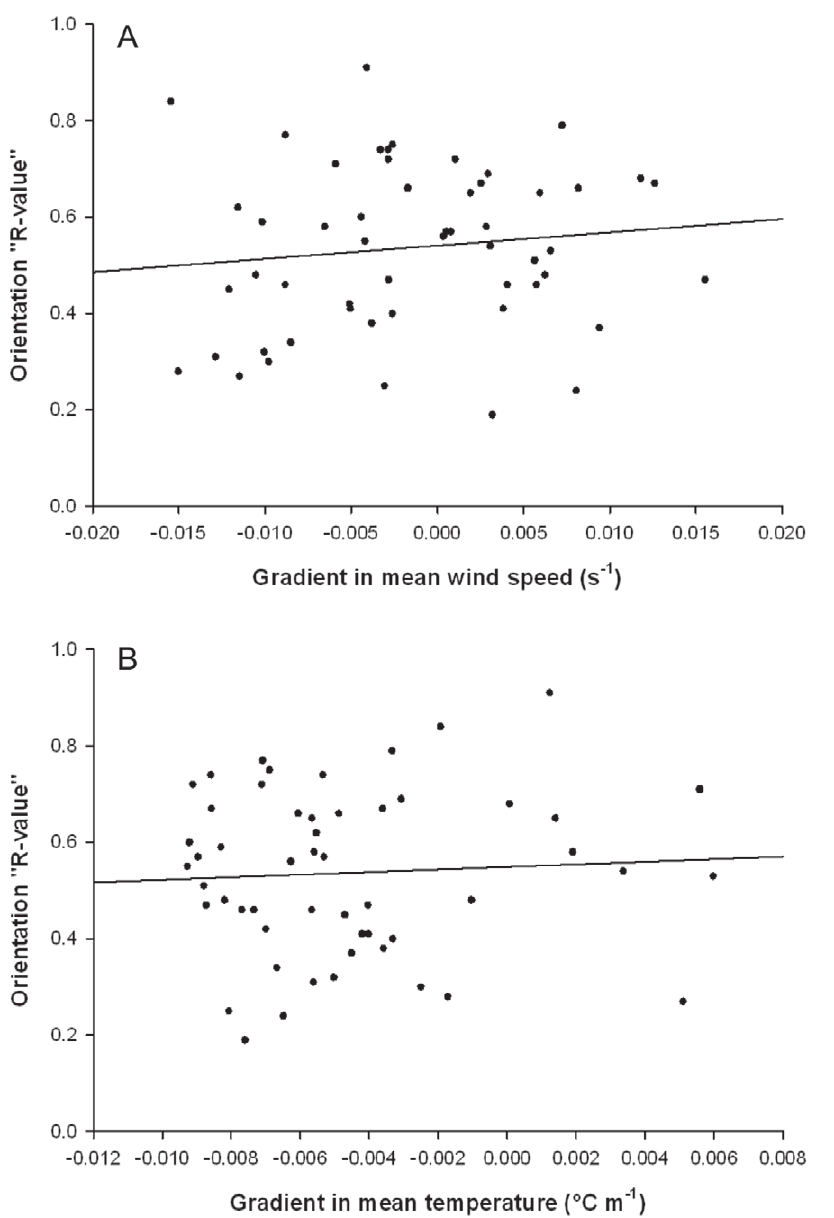
Figure 2. The ‘tightness’ of orientation direction in large insects and gradients in wind speed and temperature. Linear regression analyses for N=53 nocturnal ‘events’ (see text) composed of large insects ( . 80 mg) ( A ) Orientation ‘R-value’ and gradient in mean wind speed shear: df =1, 51, R 2 , 0.001, F=0.75, P=0.389. ( B ) Orientation ‘R-value’ and gradient in the mean temperature: df =1, 51, R 2 , 0.001, F=0.20, P=0.660. doi:10.1371/journal.pone.0015758.g002 average to zero, are Gaussian, homogeneous and at the smallest scales isotropic. The simplest model encapsulating this scenario is the classic Langevin equation,